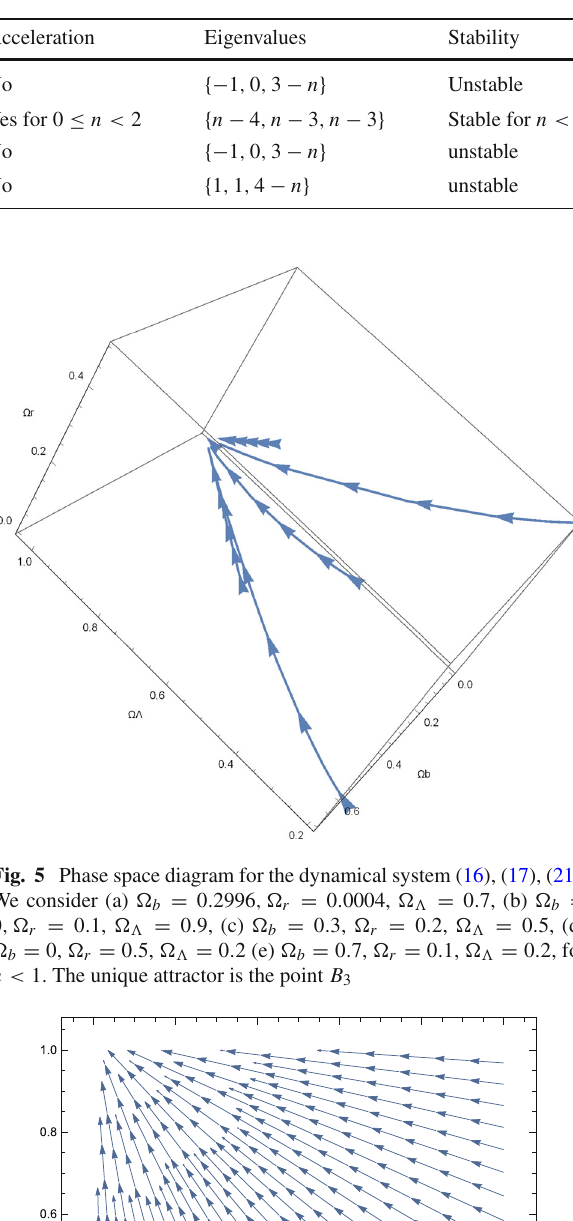
= 0 . 7, (cid:8) = 0 . 1, (cid:8) (cid:2) = 0 . 2, for b r